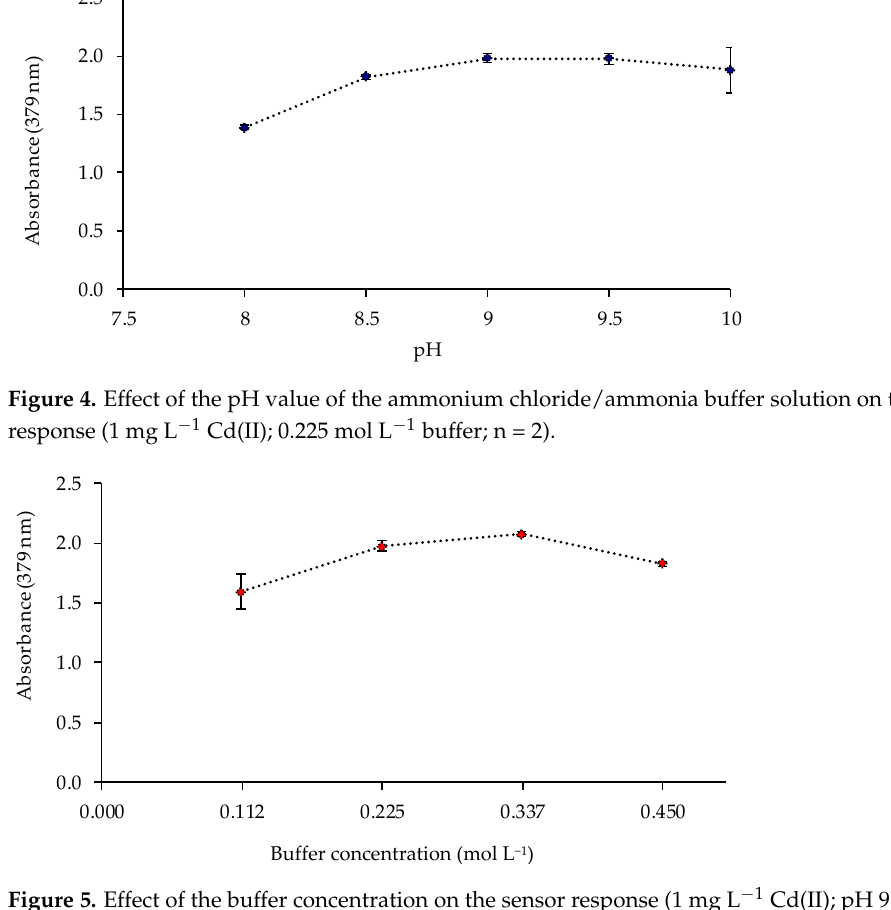
Figure 5. Effect of the buffer concentration on the sensor response (1 mg L − 1 Cd(II); pH 9.5; n = 2).